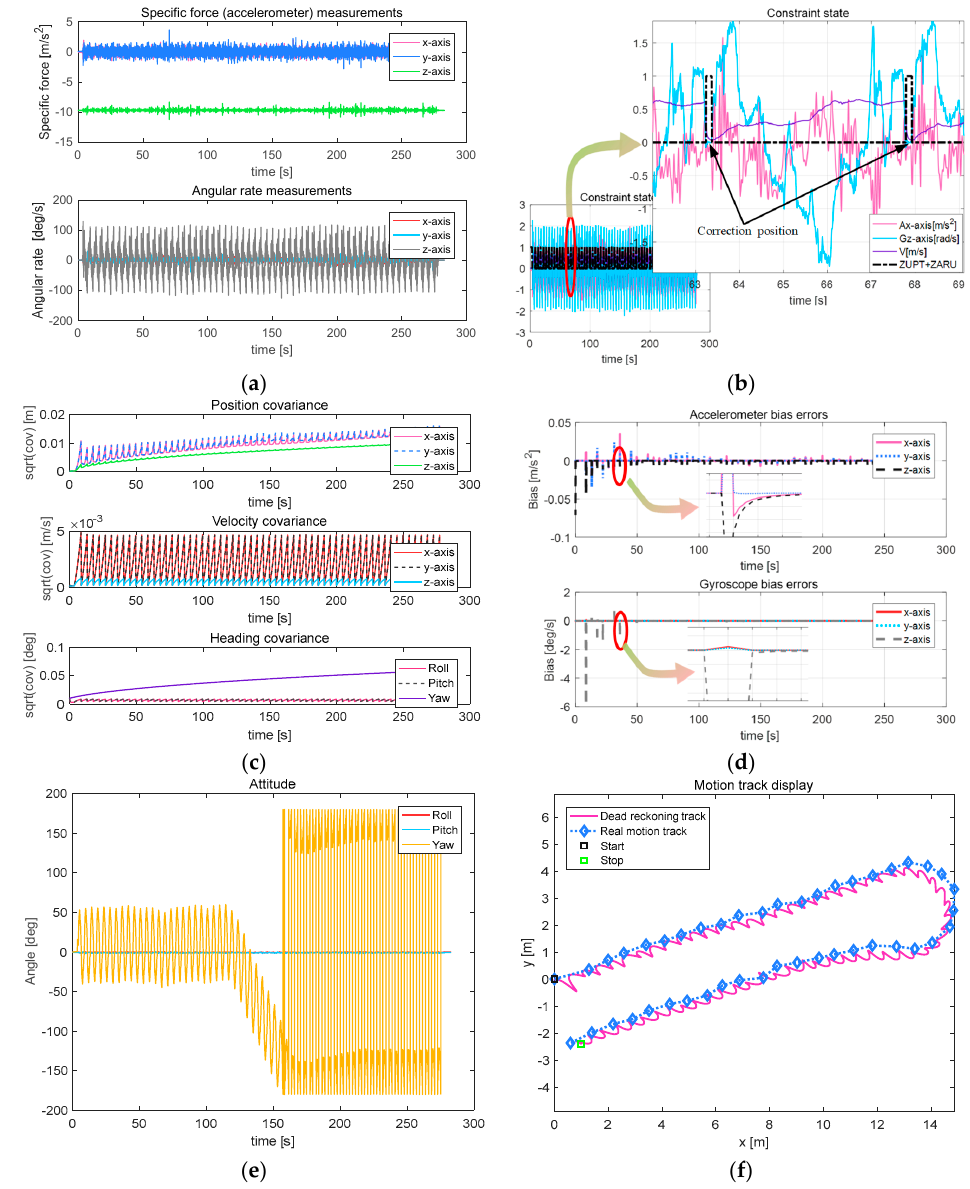
Figure 16. Parameters related to turn-back motion. ( a ) Output result of the MEMS IMU; ( b ) Constraint state; ( c ) Result of the covariance; ( d ) Bias errors; ( e ) Attitude of the snake robot; ( f ) Moving path of the snake robot.